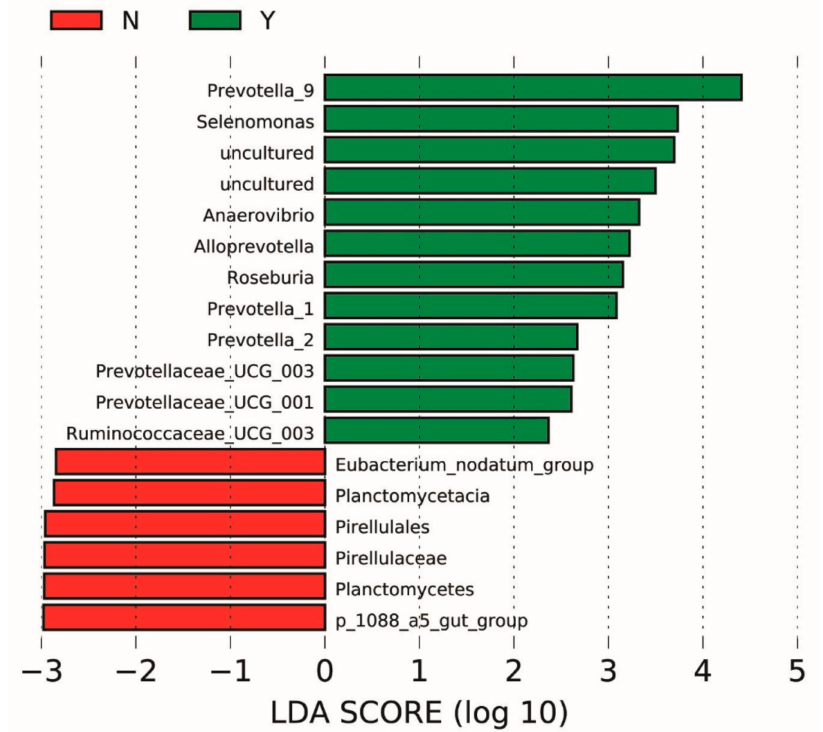
Figure 6. Predicted biological effect sizes of differential taxa using linear discriminant analysis (LDA) in the fecal microbiome of pigs at days post inoculation (dpi) 0 that either did (Y) or did not (N) develop clinical swine dysentery in the 42 d following inoculation with Brachyspira hyodysenteriae . The histogram of LDA scores calculated by LEfSe reveals differentially abundant taxa in the fecal microbiome of the two groups (red = N; green = Y) including overabundance of Prevotella spp. in pigs that developed clinical swine dysentery after